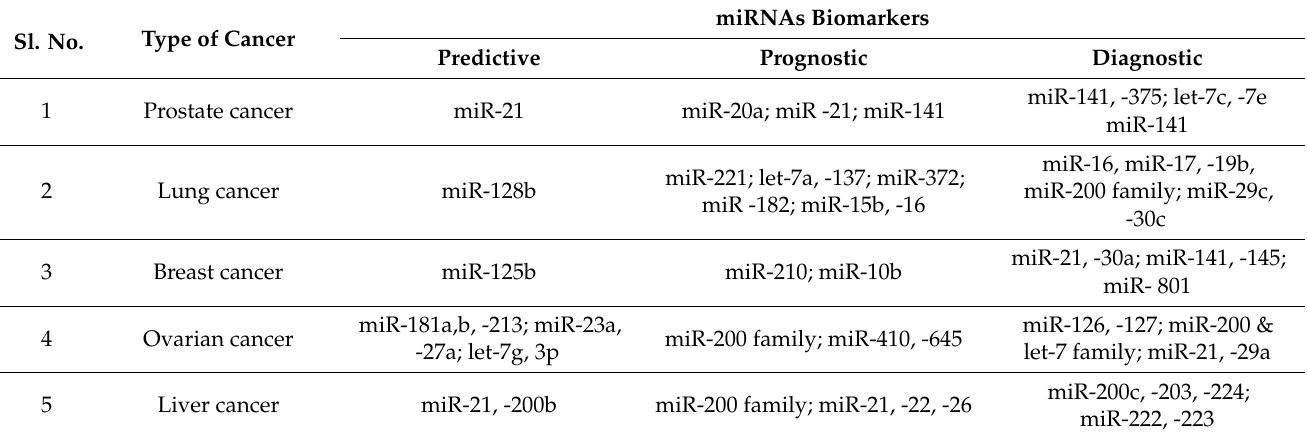
Table 2. miRNAs biomarkers and their role in various types of cancer [11,95,99,107]. Sl.